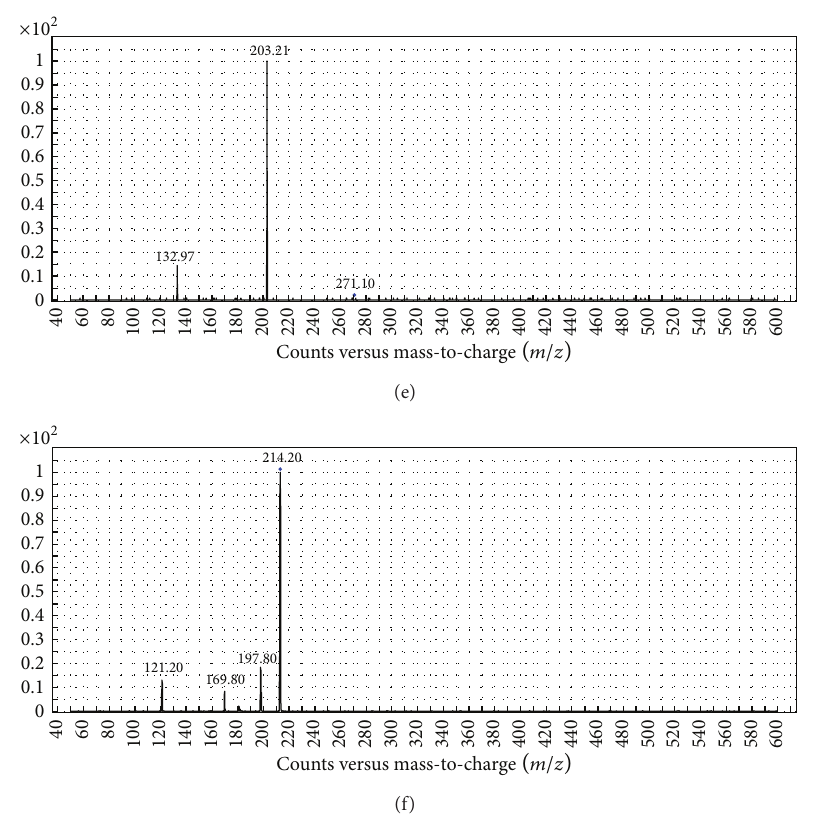
Figure 2: (a) ESI mass spectrum of compound 3d [M + H] + ion ( m/z 442.10). (b) MS 2 spectrum of m/z 442.10. (c) In-source fragmentation of compound 3d . (d) MS 2 spectrum of m/z 374.10. (e) MS 2 spectrum of m/z 271.10. (f) MS 2 spectrum of m/z